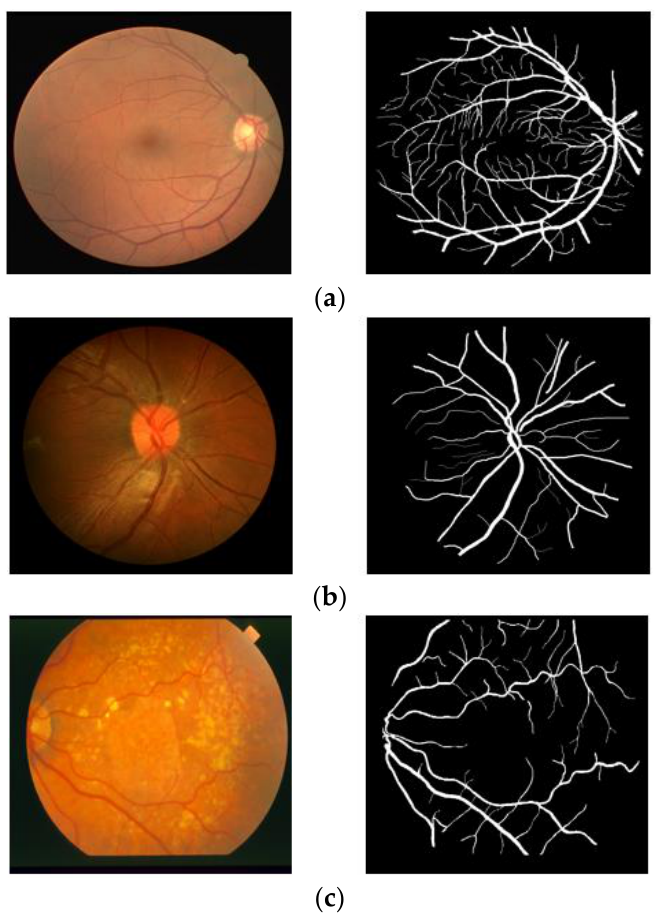
Figure 4. Example fundus images used in our experiments. ( a – c ) are examples taken from the DRIVE, CHASE-DB1, and STARE datasets, respectively. Table 4. Description of the DRIVE, STARE, and CHASE-DB1 datasets and experimentation de- tails.